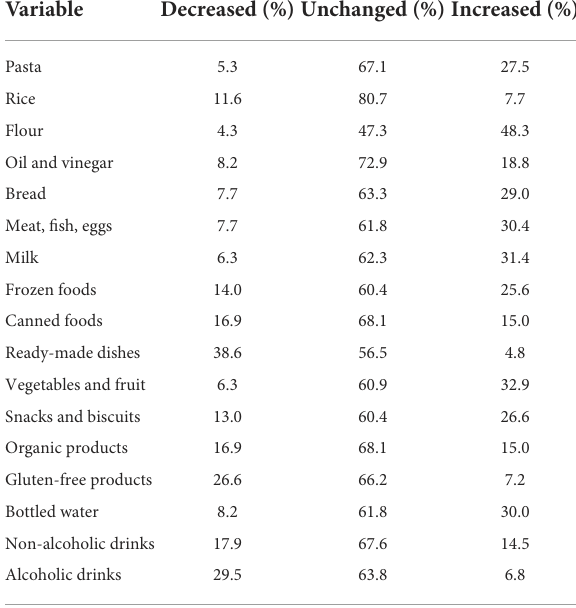
TABLE 2 Summary statistics regarding purchasing purchases (on a scale of 1–5).